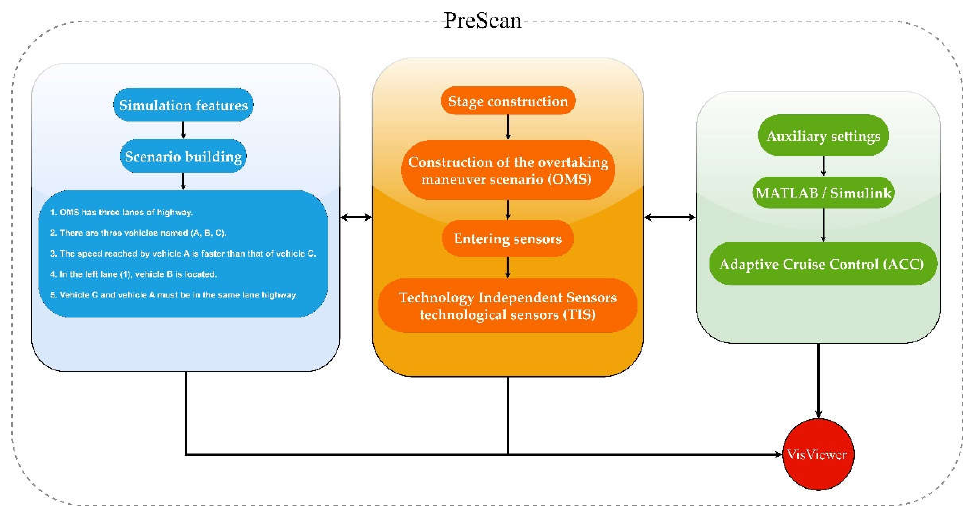
Figure 1. The flowchart of the method developed for the overtaking maneuver in